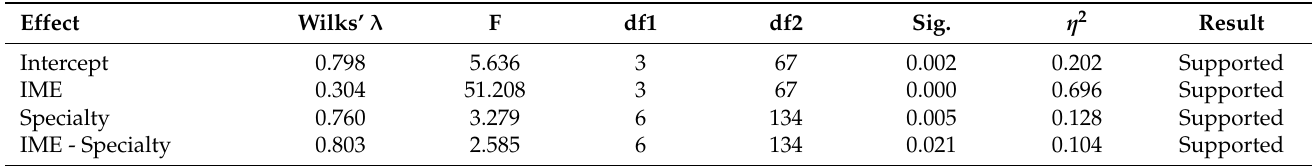
Table 8. Multivariate analysis of covariance: test of overall effect.